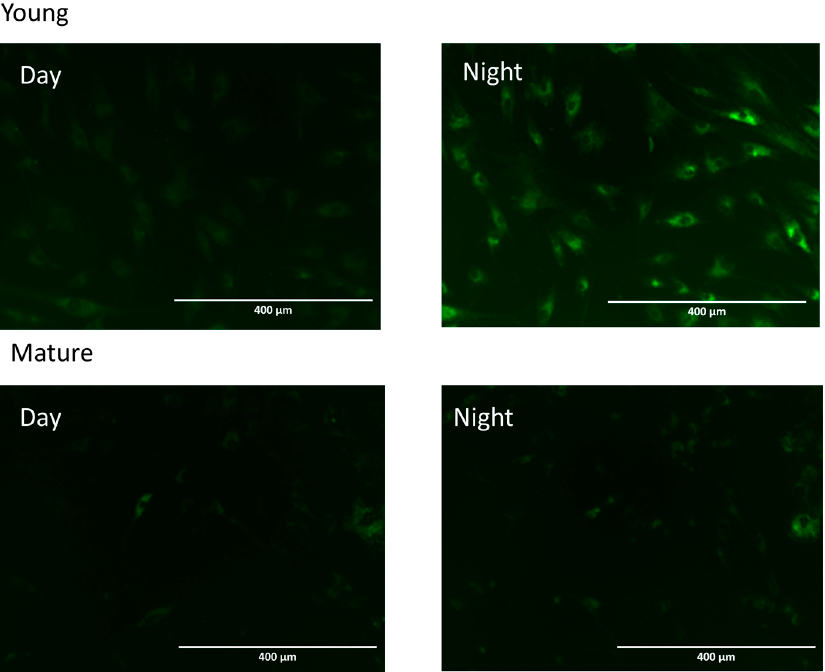
Figure 5. Cell synchronization was induced by nutrient deprivation followed by nutrient repletion, which induced a temporal rhythm that showed an increase of autophagy LC3B by 77.9% in young fibroblasts, whereas this effect was absent in aged fibroblasts. LC3B expression was determined by RT-PCR and normalized to glyceraldehyde 3-phosphate dehydrogenase (GAPDH) housekeeping genes ( n = 3). In addition, temporal rhythm was followed over a 24 h period through fluorescent imaging specific to LC3B, showing the higher fluorescence at night versus day in young human fibroblasts but lost in aging human fibroblasts. Used with permission, Journal of Cosmetic Science , Pernodet et al. [65].